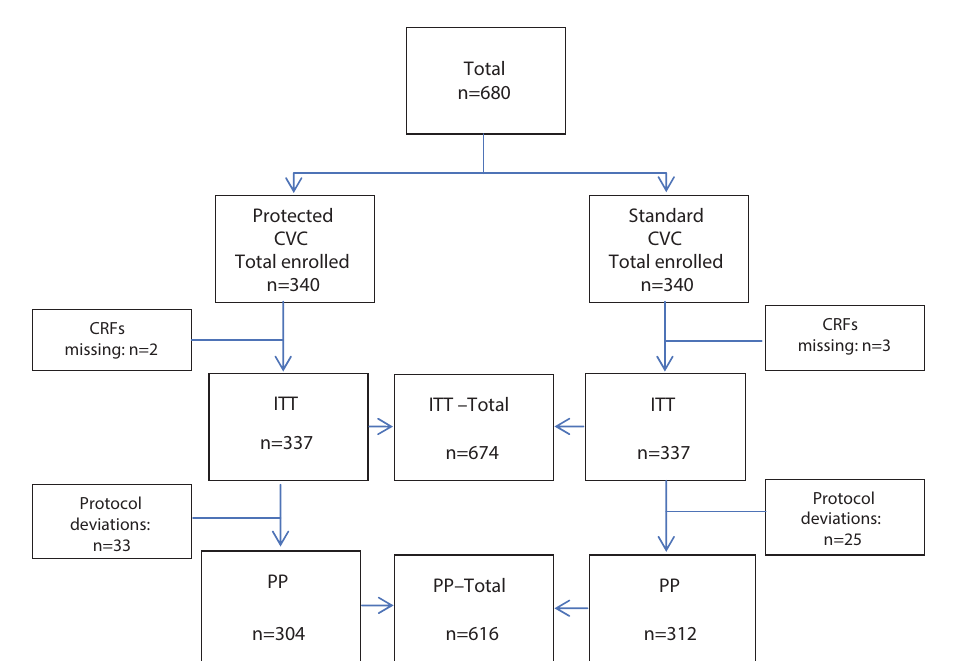
Fig. 2. Relative number of infections in the Certofix® protect and the Certofix® standard group at time of interim analysis and end of